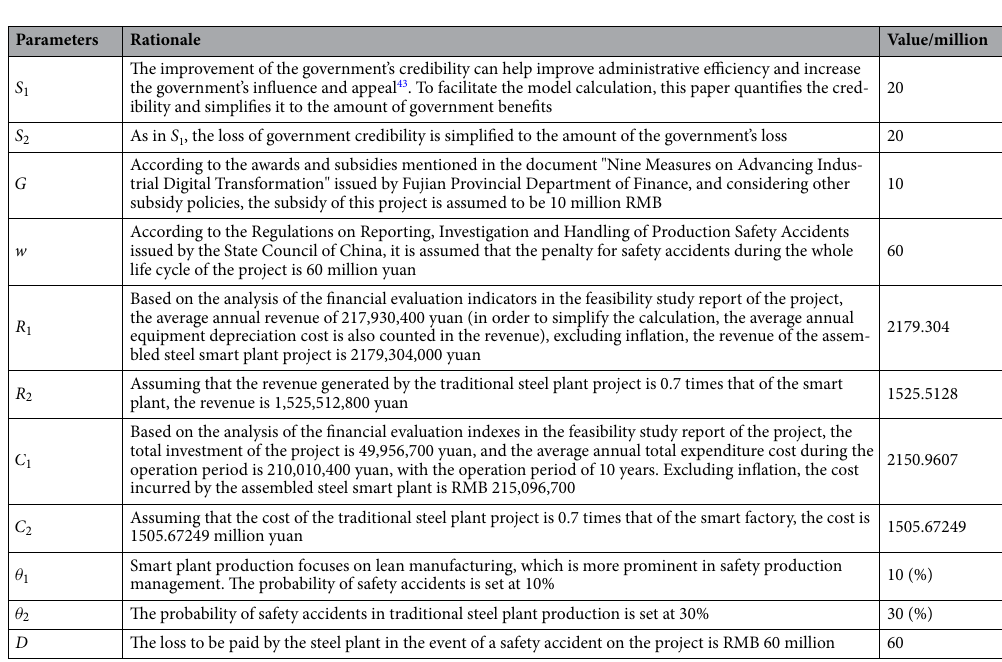
Table 5. Initial parameter values of the evolutionary game